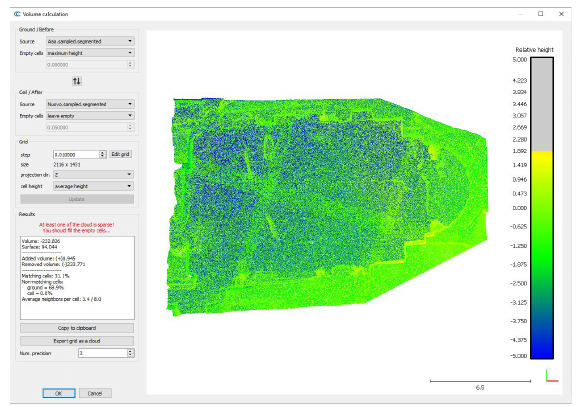
Figure 7. 2.5D volume estimation using CloudCompare software on the Nymphaeum of Punta Epitaffio.